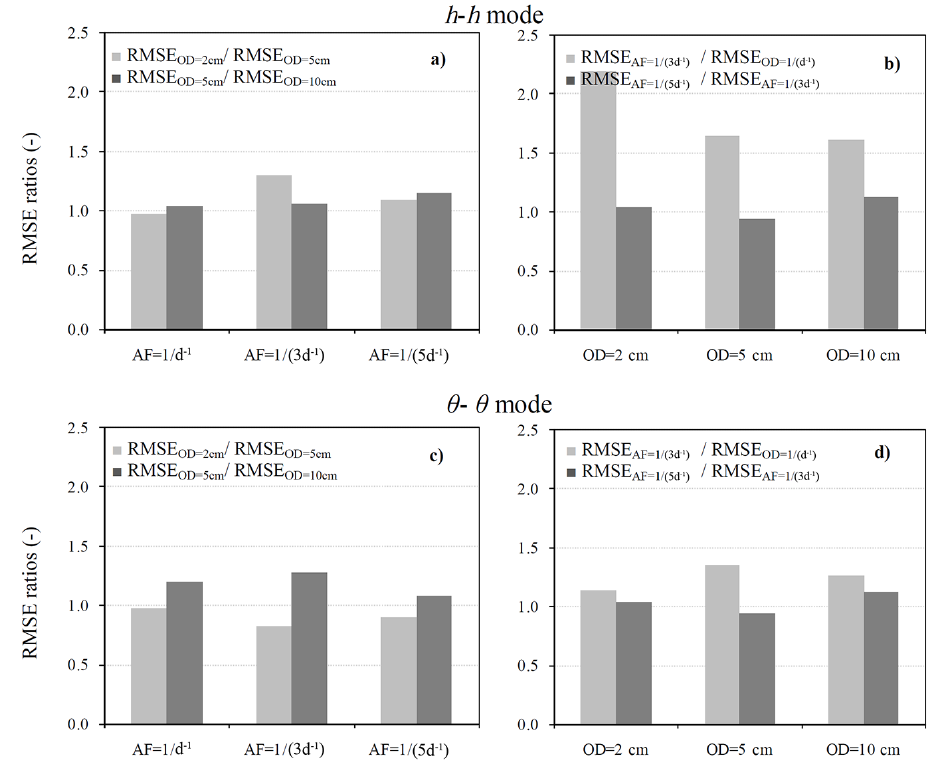
Figure 5. Ratios of the average RMSE, involving the last 15 days of simulations and the six initial guessed parameter sets, computed between contiguously sampled (a, c) observation depths (OD) and (b, d) assimilation frequencies (AF), with the DSUKF